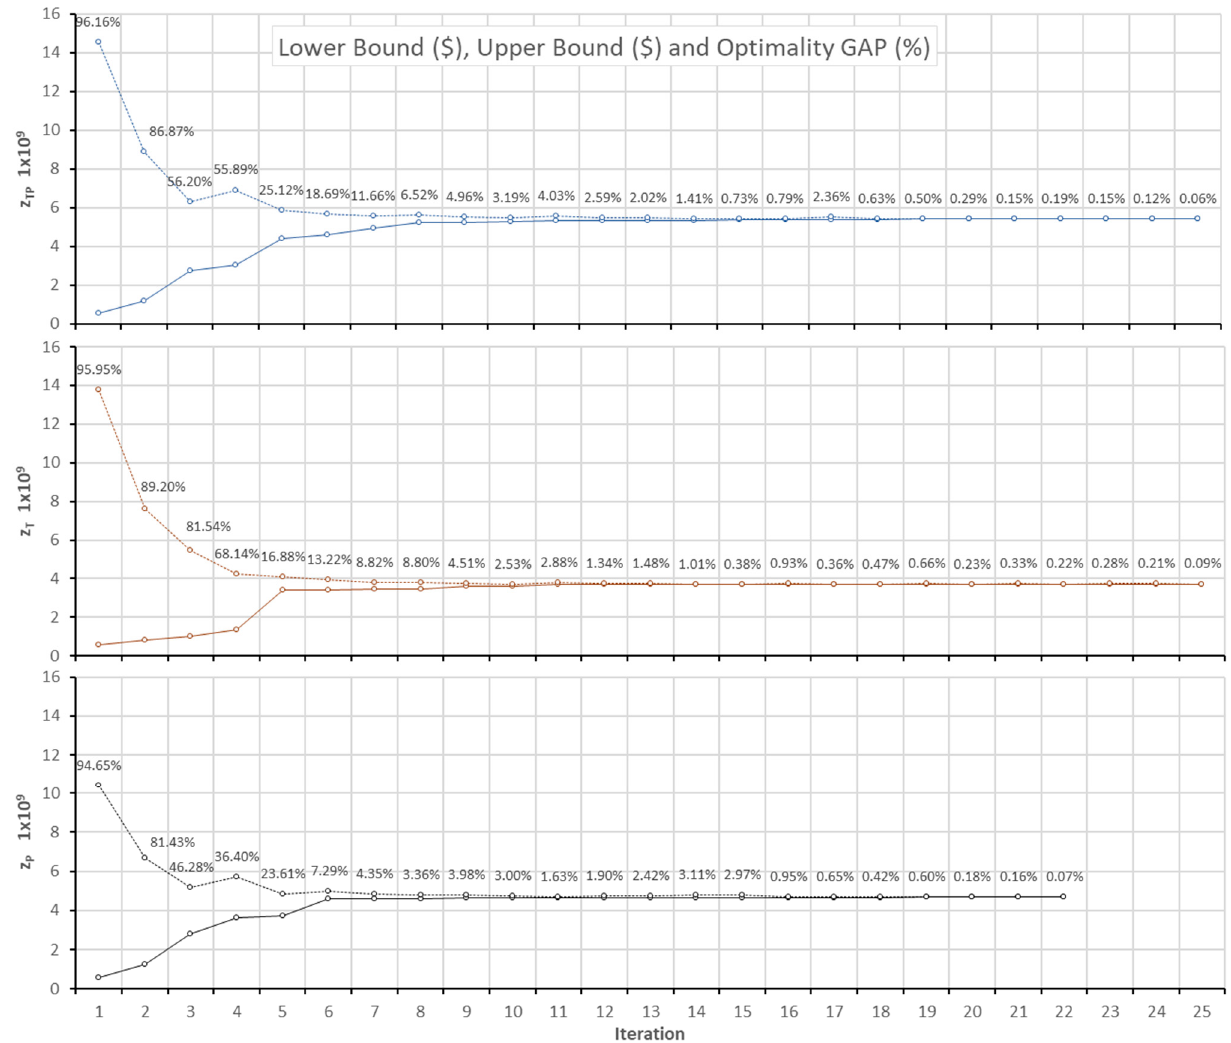
Figure 12. System capacity and